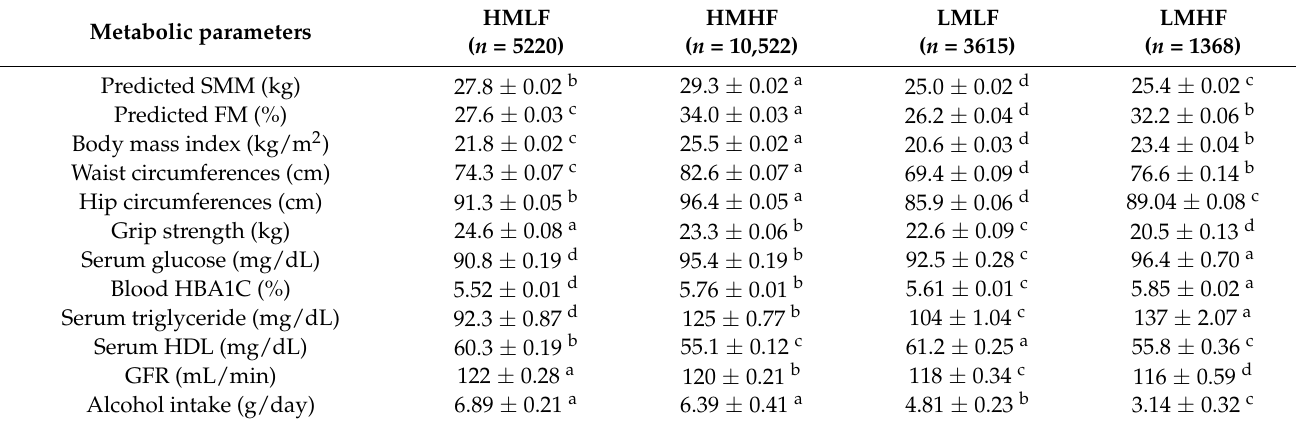
Table 4. According to skeletal muscle mass (SMM) and fat mass (FM) in women at the urban hospital-based cohort, adjusted means and standard errors in anthropometric and biochemical